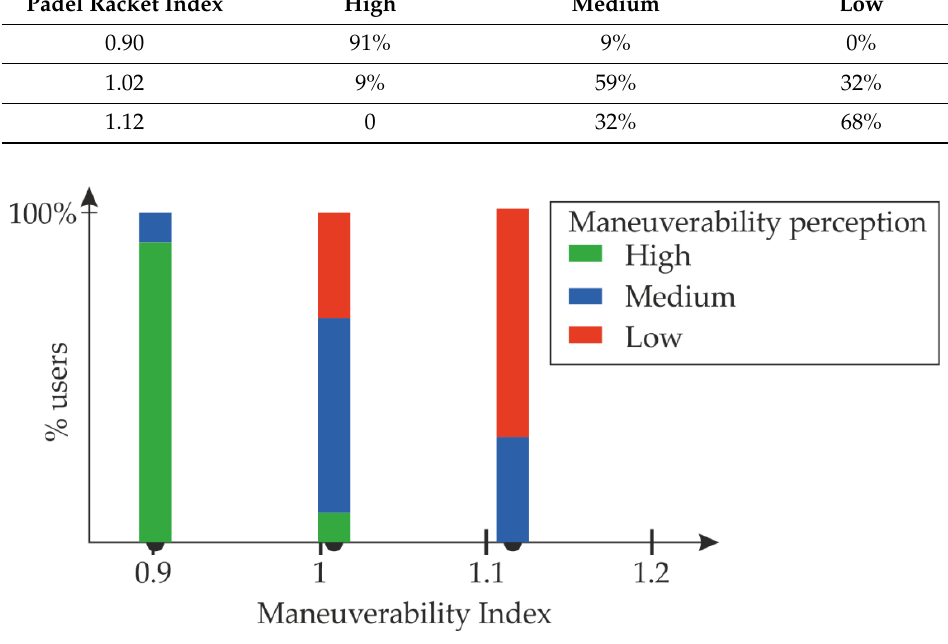
Figure 18. Results of the test with users.